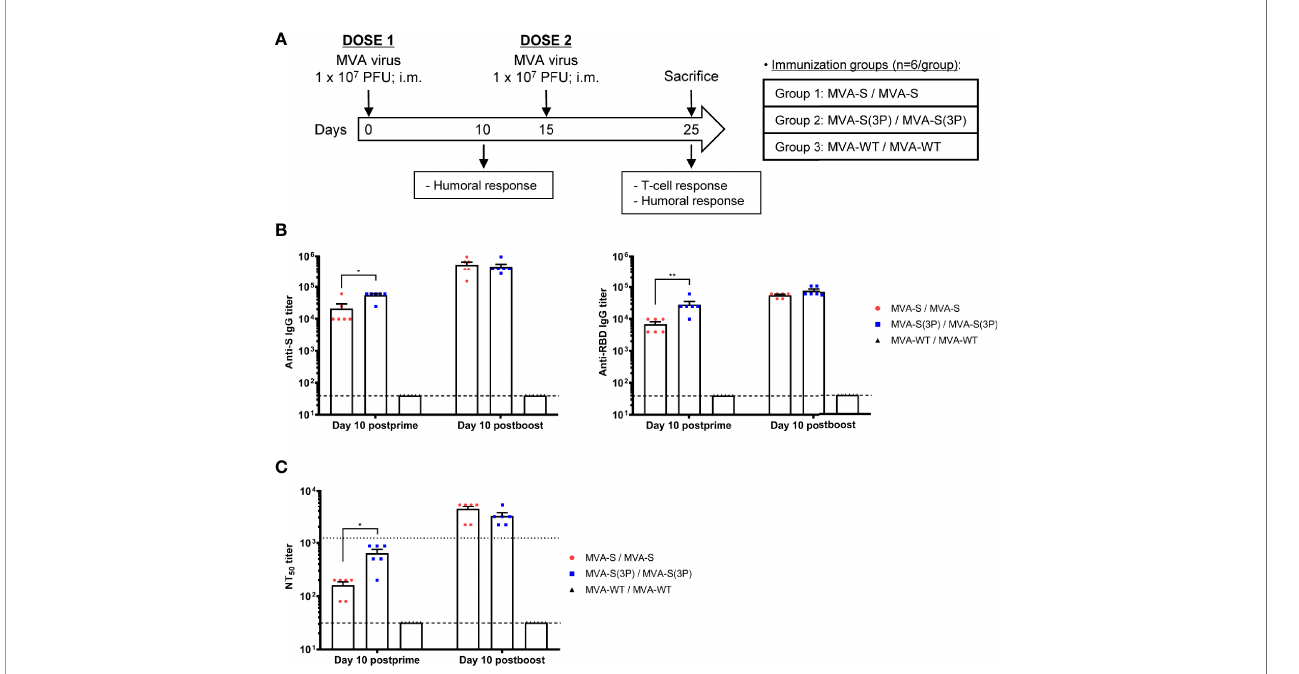
FIGURE 2 | Immunization schedule in C57BL/6 mice vaccinated with MVA-S and MVA-S(3P) vaccine candidates and humoral responses induced. (A) Immunization schedule in C57BL/6 mice. Six C57BL/6 mice per group were inoculated at days 0 and 15 (prime/boost) with vaccine candidates MVA-S or MVA-S(3P), as indicated. At day 10, post-prime mice were bled to obtain serum samples. Mice were sacri fi ced 10 days after the boost (day 25) to analyze the adaptive SARS-CoV- 2-speci fi c T-cell and humoral immune responses. PFU: Plaque-forming units; i.m.: intramuscular. (B) Titers of IgG antibodies speci fi c for the S (left) and RBD (right) proteins (Wuhan strain) at 10 days post-prime or 10 days post-boost. Determined by ELISA in individual mouse serum samples collected at 10 days post-prime and at 10 days post-boost from immunized C57BL/6 mice. Mean values and SEM are represented. Dashed line represents the limit of detection. (C) SARS-CoV-2 neutralizing antibody titers. NT 50 titers were evaluated in individual mouse serum samples collected at 10 days post-prime and at 10 days post-boost from immunized C57BL/6 mice, using a live virus microneutralization assay. Mean NT 50 values and SEM are represented. Upper dotted line represents the levels obtained with the NIBSC 20/136 international standard plasma (containing pooled plasma obtained from 11 individuals recovered from SARS-CoV-2 infection). Bottom dotted line represented the limit of detection. Student ’ s t -test: * p < 0.05; ** p <